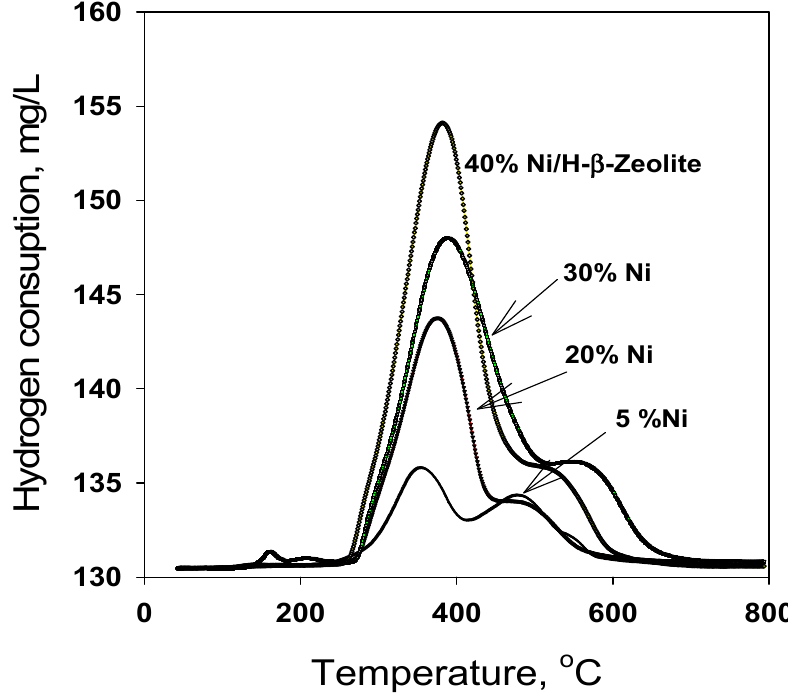
Figure 2. Temperature programmed reduction (TPR) patterns of Ni/H β -zeolite